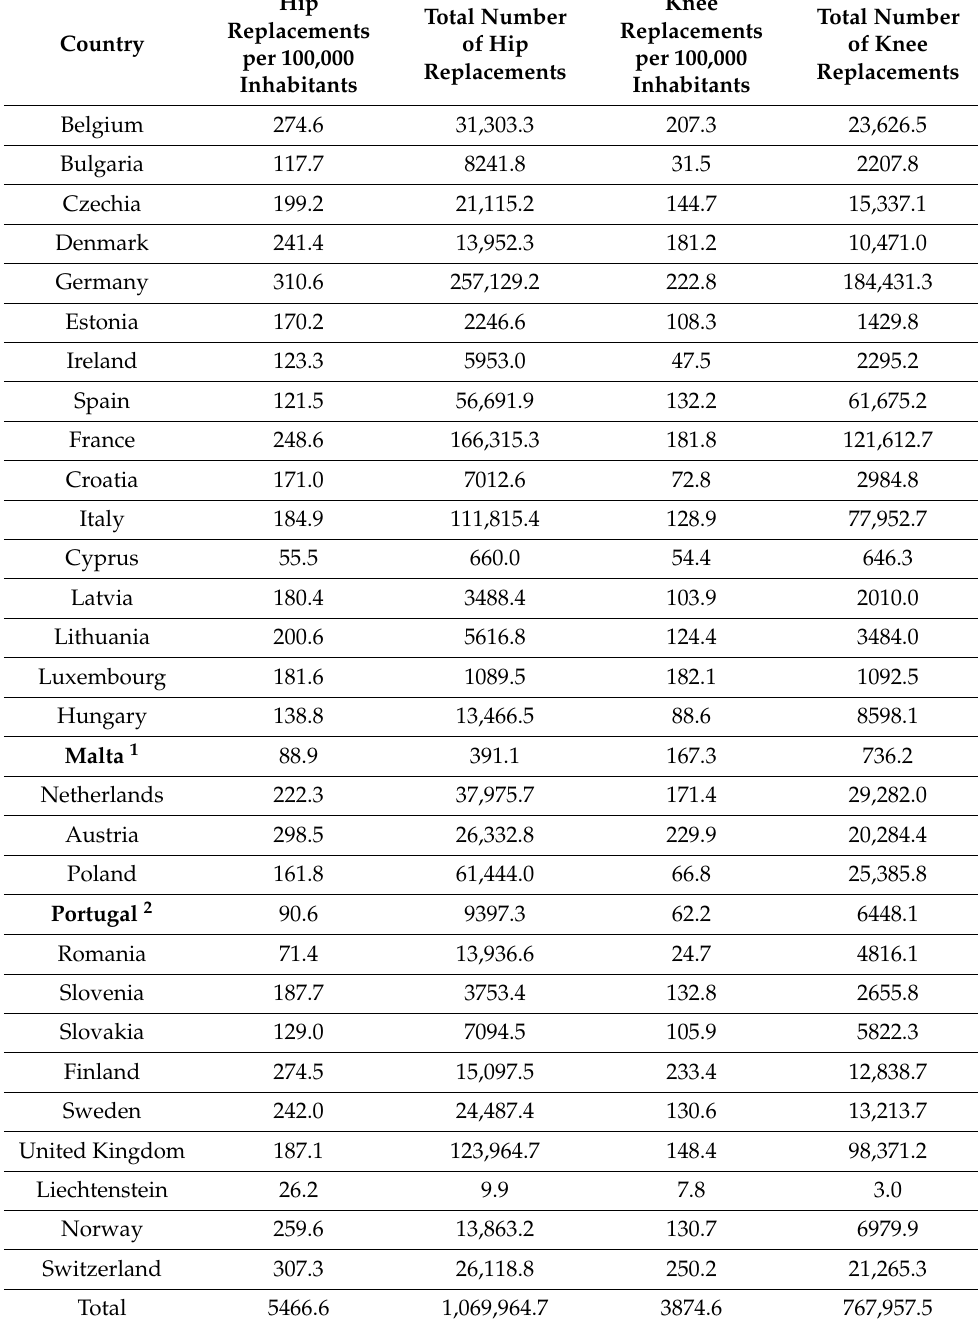
Table 1. An overview of the European statistics on the frequency of hip replacement and the frequency of total knee replacement in 2018, as provided by Eurostat [28]. Knee Hip Total Number Total Number Replacements Replacements of Knee of Hip Country per 100,000 per 100,000 Replacements Replacements Inhabitants Inhabitants 274.6 31,303.3 207.3